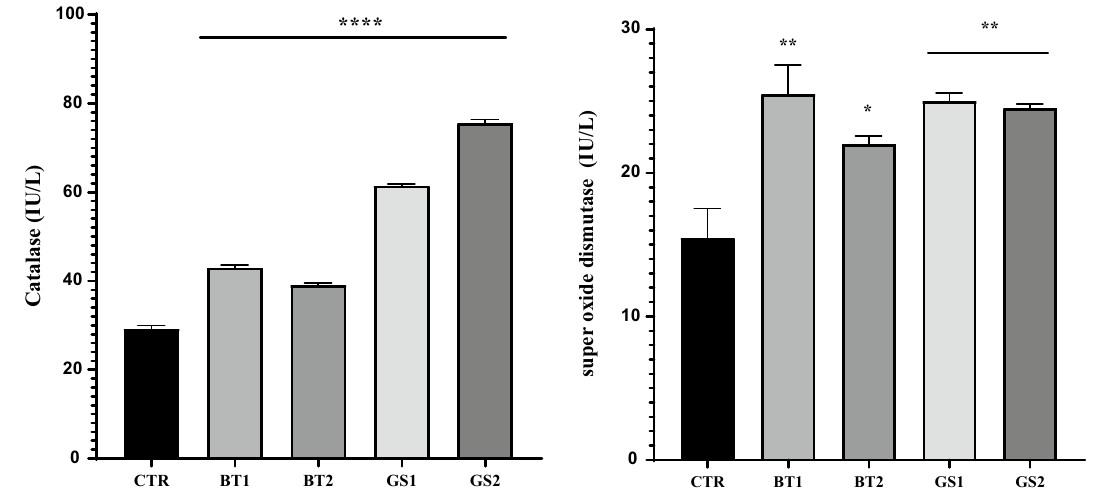
Fig. 5 Effects of supplemented tilapia rearing water with two probi- otic strains (BT, B. toyonensis and GS, G. stearothermophilus ) at lev- els of 1 or 2 × 10 5 CFU ml −1 on catalase and super oxide dismutase activity. The Dunnett's multiple comparison of group means was